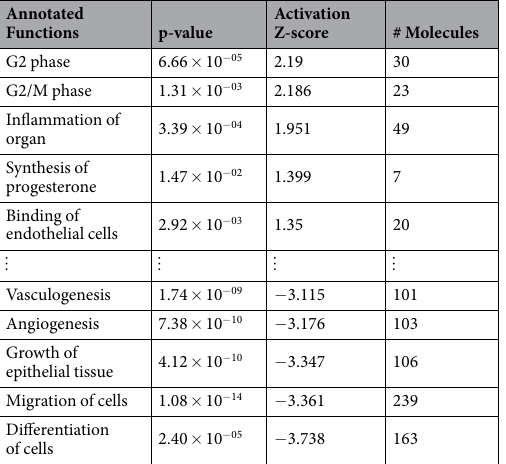
Table 4. Top five increased and decreased functions. Note that the annotated functions are ordered using the activation Z-score. Companion p-values and the number (#) of molecules present in each function are also included.